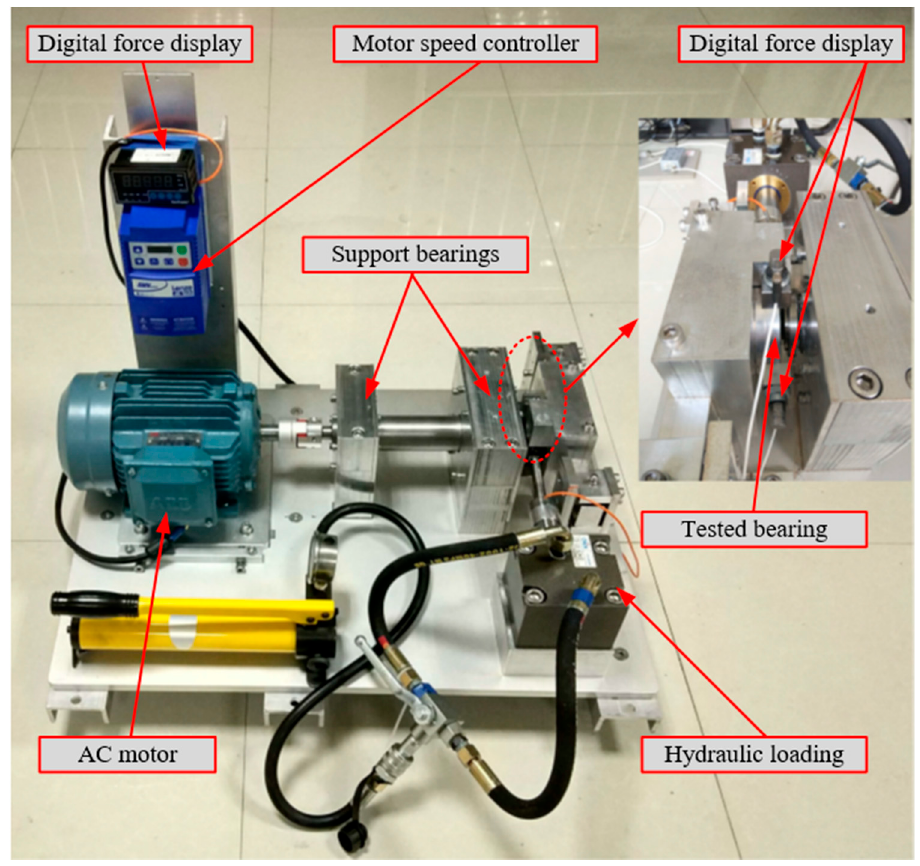
Figure 2. Experimental setup.